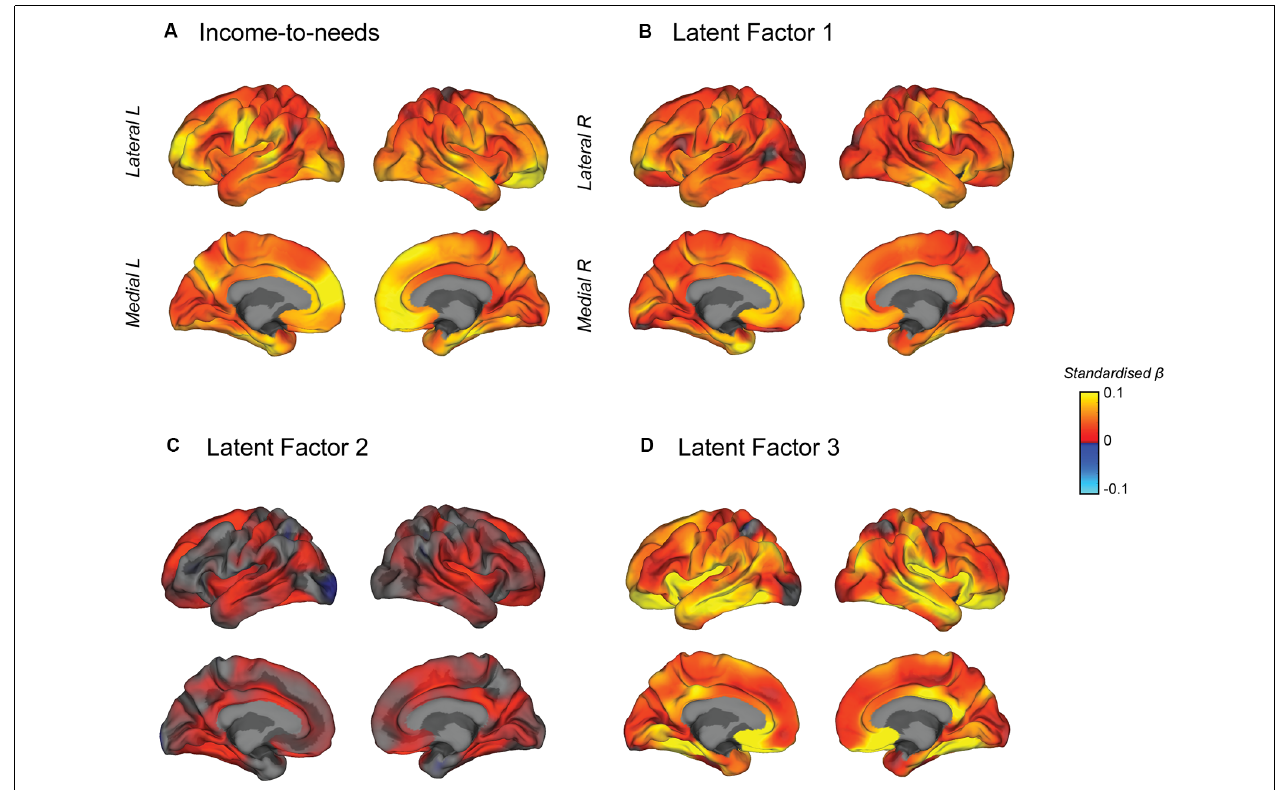
FIGURE 6 | Mass univariate vertex-wise estimated effect size maps predicting surface area from each independent variable, (A) the INR, (B) latent factor 1, (C) latent factor 2, and (D) latent factor 3, were created using general linear models at each vertex controlling for age, sex, race/ethnicity, and scanner ID. Maps b–d also included the INR and the other latent factors as additional covariates such that these maps show the unique contribution of each latent factor predicting surface area. The maps show unthresholded standardized beta coefficients. All of the independent variables showed positive effects with the surface